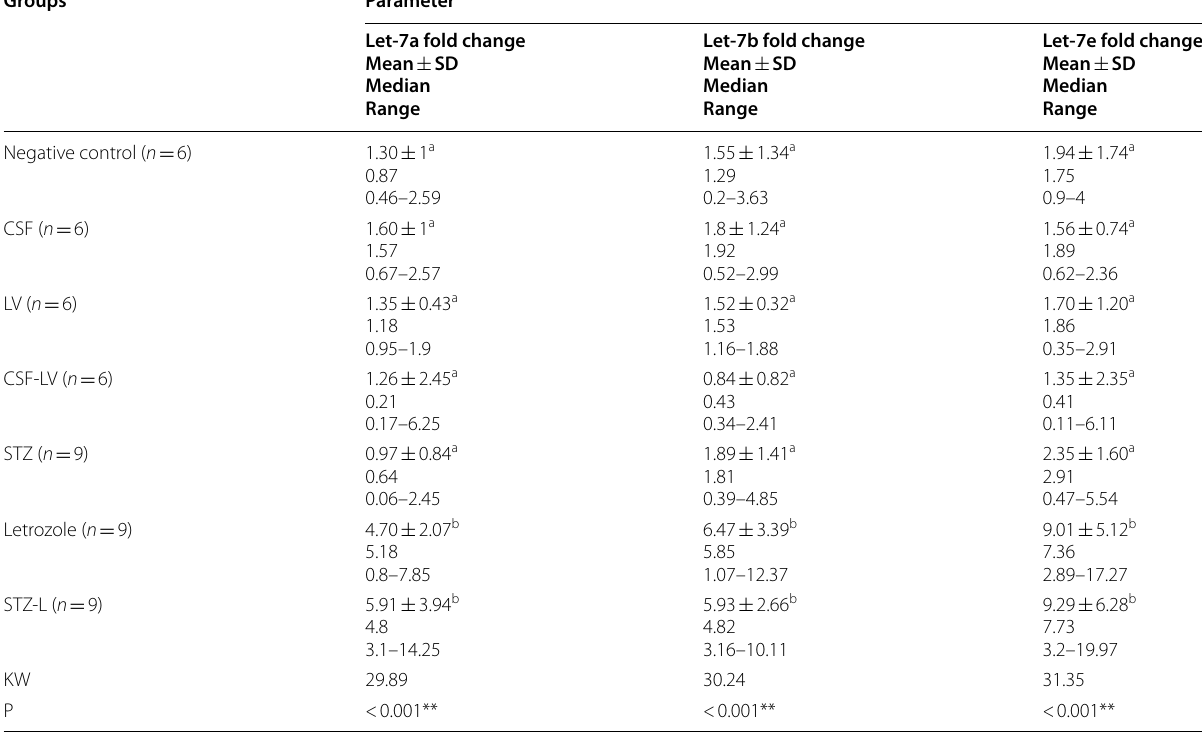
Table 2 Let‑7 miRNAs expression (in fold change) in the studied groups